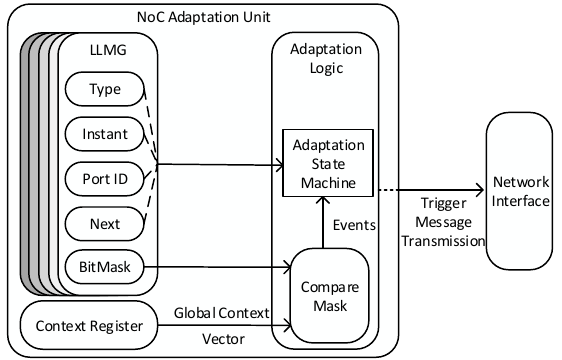
Figure 8. Internal structure of the NoC adaptation